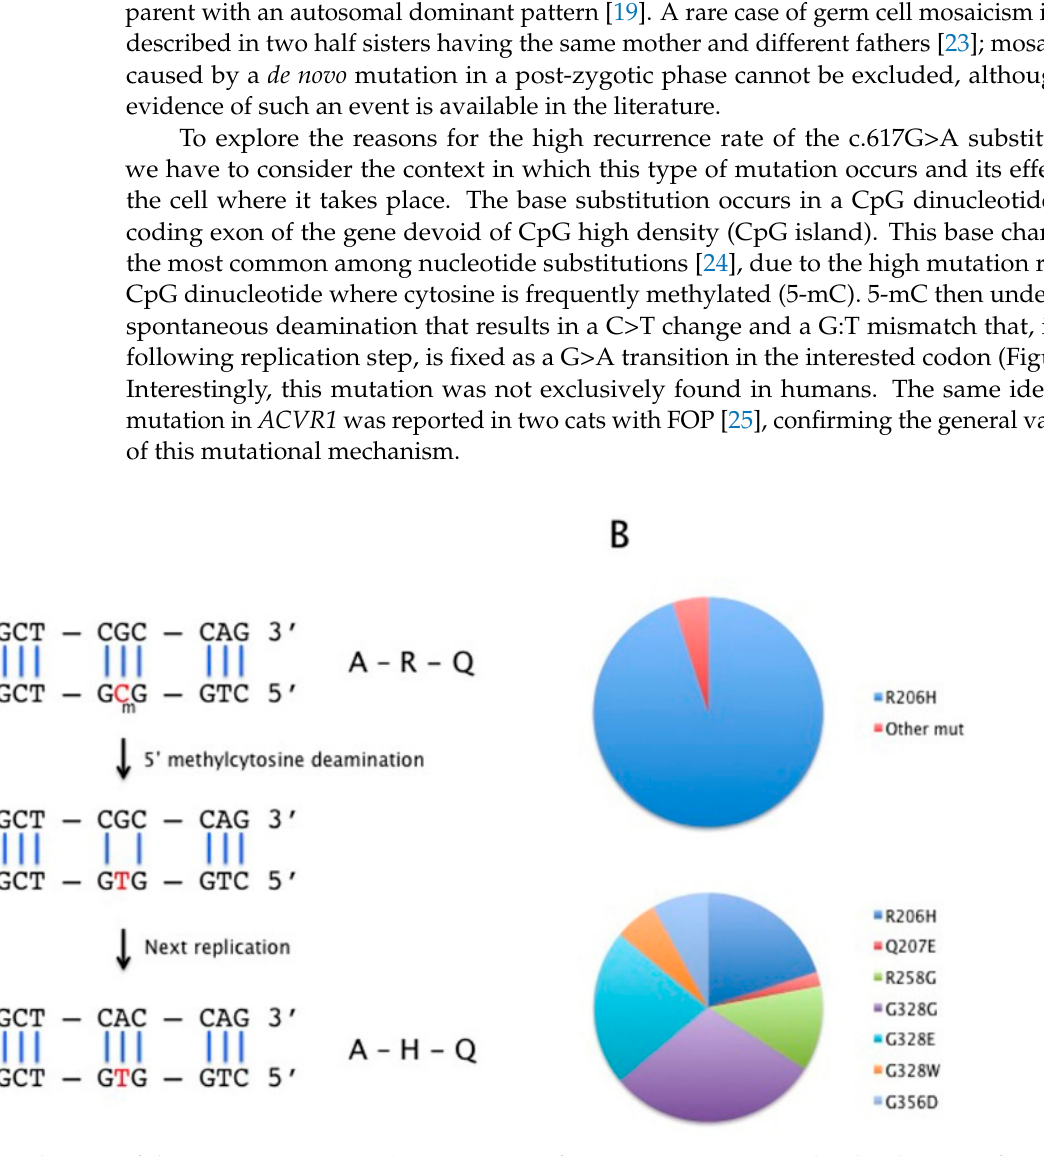
Figure 1. ( A ) Mechanism of the G>A mutagenesis; ( B ) Percentage of ACVR1 mutations in Fibrodysplasia Ossificans Progressiva (FOP) (upper) and in Diffuse Intrinsic Pontine Glioma (DIPG) (lower). The red color in part A indicates the interested nucleotide.